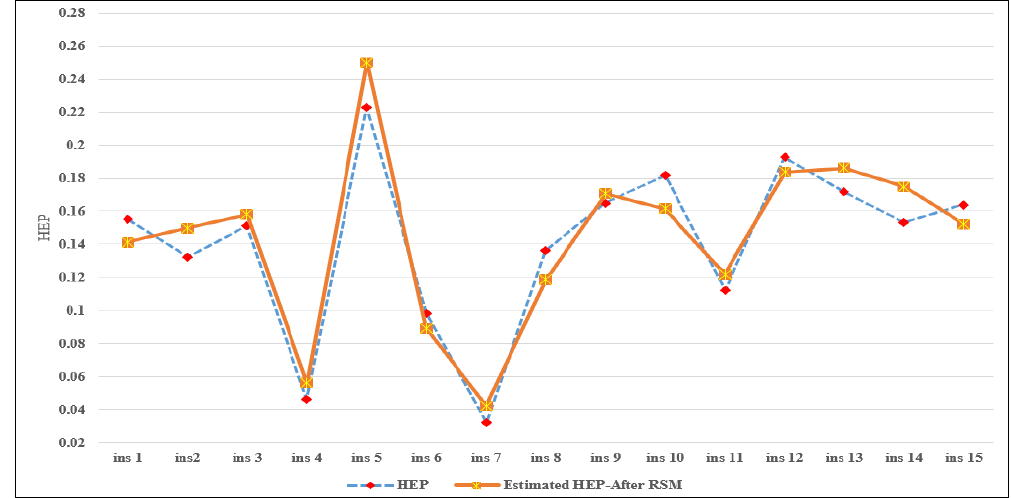
Fig. 7. The original HEP vs. HEP proposed By ANN after RSM implementation